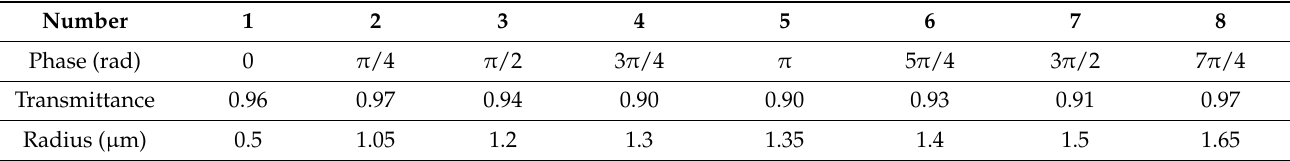
Figure 1. ( a ) Schematic of a unit cell of the PIM. ( b ) The transmittance and phase changes of the nanorods at 8 µ m height. ( c ) The relationship between the transmittance and the height and radius of the nanorods. ( d ) The relationship between the propagation phase and the height and radius of the nanorods. Table 1. The UCL of the